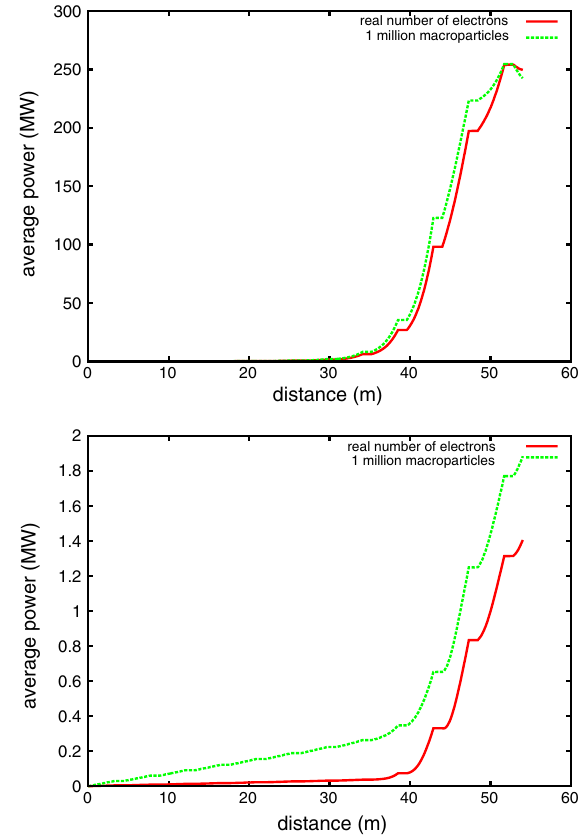
FIG. 13. Evolution of the average x-ray radiation power at 1 nm (top) and 0.33 nm (bottom) wavelength inside the first undulator section of the SASE FEL scheme with the real number of electrons (red) and the one million macroparticles